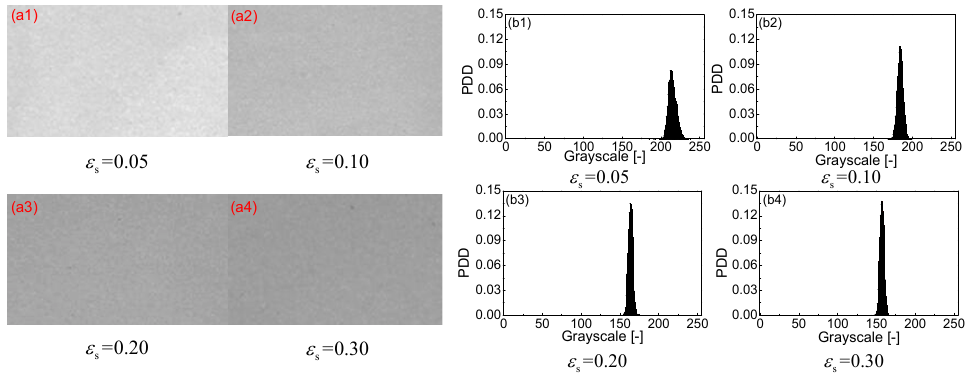
Figure 10. Particle image under different solids holdups for Group B sand particlea.